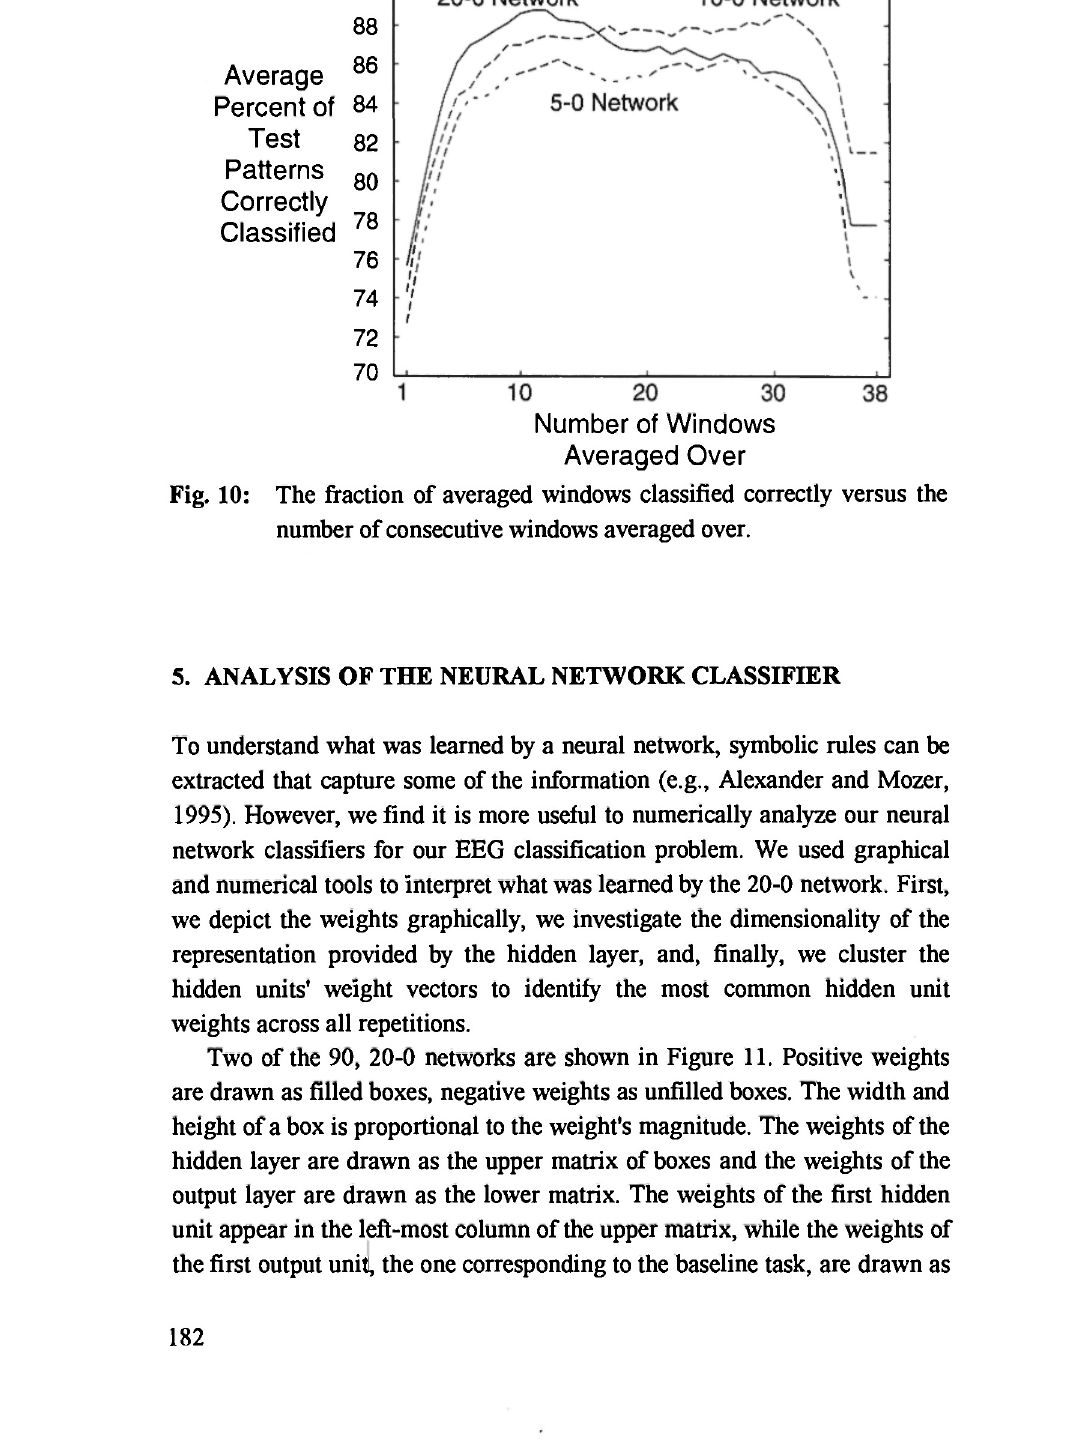
Number of Windows Averaged Fig. 10: The fraction of averaged windows classified correctly versus the number of consecutive windows averaged over.